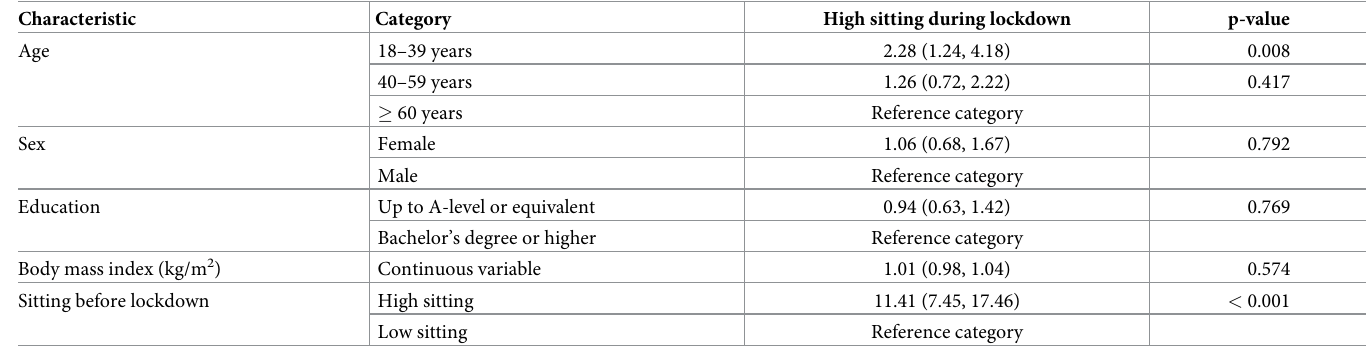
Table 4. Associations of demographic factors and pre-lockdown weekday sitting with weekday sitting during lockdown (reference category = low sitting; n = 699). Characteristic